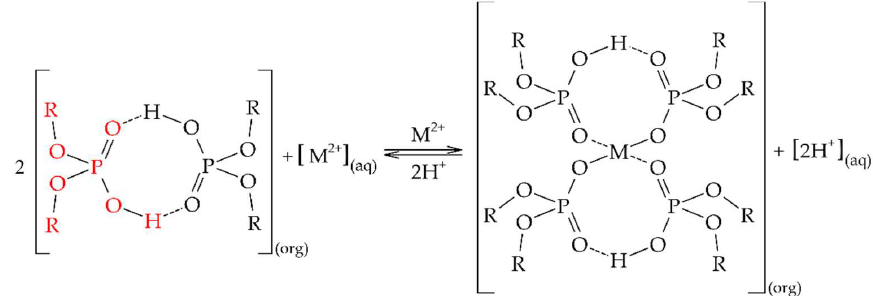
Figure 2. Extraction mechanism for D2EHPA with R = C 8 H 17 , adapted from Wilson et al.